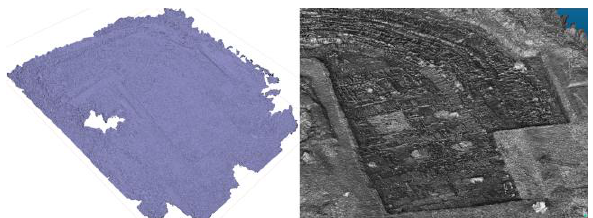
Figure 7: 3D model of a fragment of the fortified settlement in mesh form.